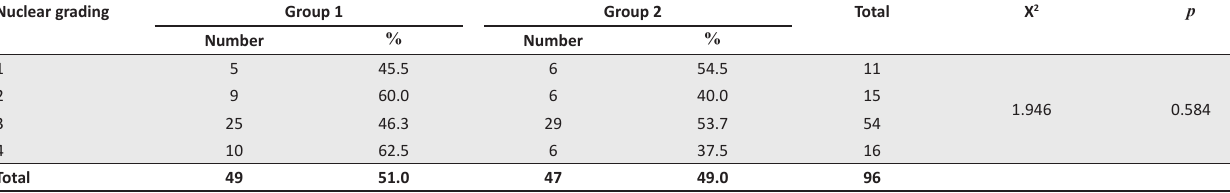
TABLE 3: Comparison between experienced and trainee surgeons according to preoperative endothelium specular characteristics. Variable Density/ µ m 2 Coefficient of variation % (CV) Independent sample T -test, degree of freedom = 98. TABLE 4: The association between study groups and nuclear cataract grading. Nuclear grading